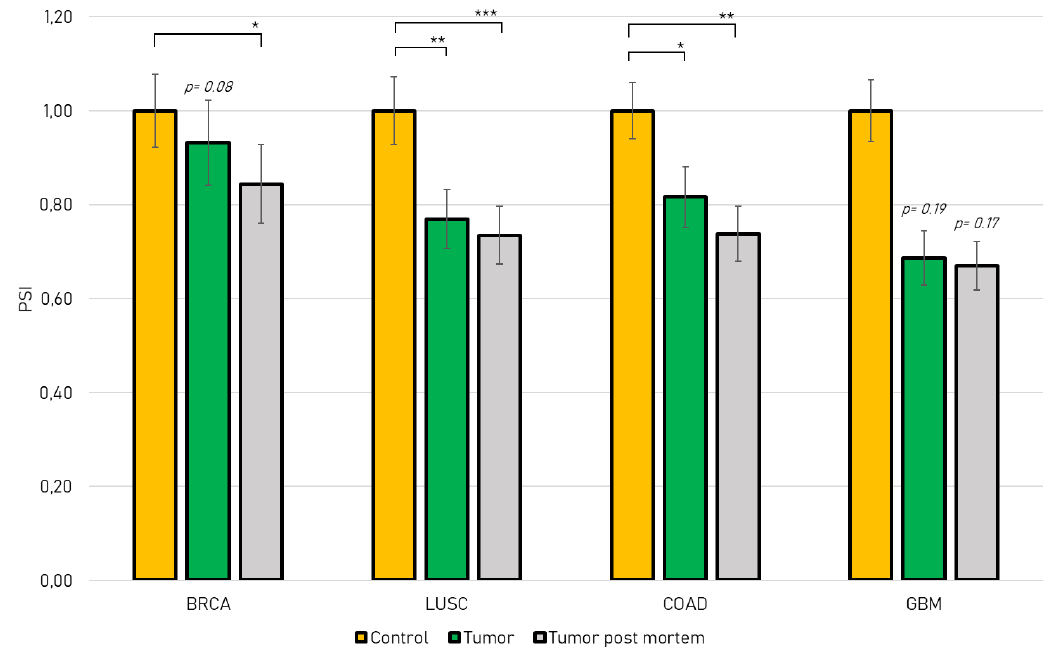
Figure 2. TCGA SpliceSeq Database search showing Percent Spliced In values (PSI) of jmjd6 exon 5 (resulting in JMJD6-Ex5) in Breast Invasive Carcinoma (BRCA), Lung Squamous Cell Carcinoma (LUSC), Colon Adenocarcinoma (COAD) and Glioblastoma (GBM). Tumor samples from patients (green bars) and samples from post-mortem patients (grey bars) were normalized to a healthy control group (yellow bars). Mean values ± SEM are presented and a t-test was conducted (* p < 0.05, ** p < 0.01, *** p < 0.001).